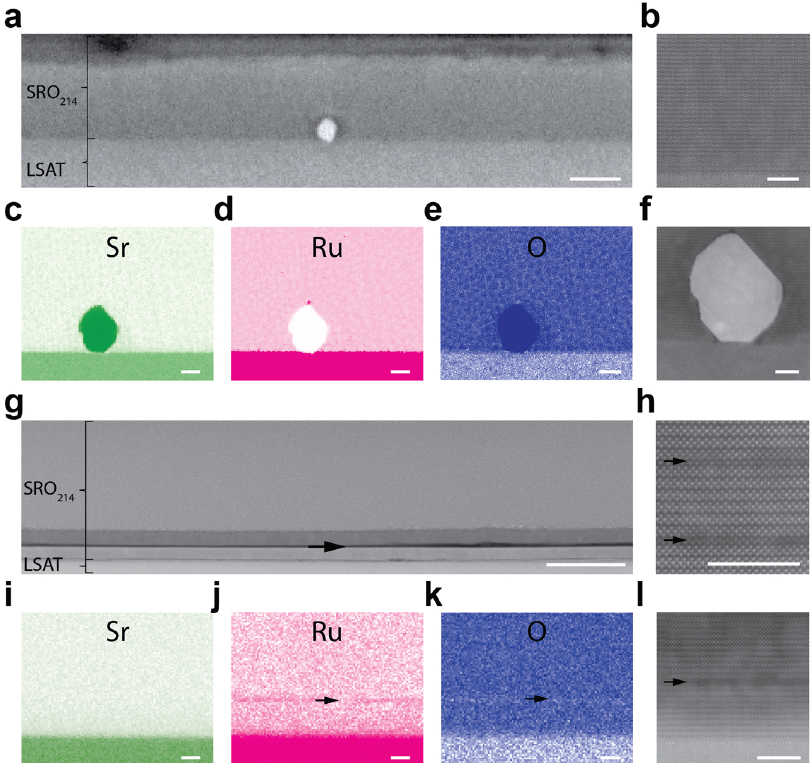
Fig. 3 Structural and chemical properties of Sr 2 RuO 4 fi lms. a – f Scanning transmission electron microscopy STEM micrographs of a superconducting fi lm of a thickness t = 66 nm ( a ) showing inclusions at the Sr 2 RuO 4 /(La 0.3 Sr 0.7 )(Al 0.65 Ta 0.35 )O 3 (LSAT) interface and high resolution HR-STEM of an area close to the same interface in ( b ). EDX maps of the inclusions in a are shown in c - e for Sr ( c ), Ru ( d ) and O ( e ) with a HR-STEM micrograph of the inclusion in f . g – l STEM micrograph of a t = 41 nm metallic fi lm ( g ) showing an interface layer of different stoichiometry (dark black line indicated with an arrow) to the rest of the fi lm with corresponding energy-dispersive X-ray EDX maps for Sr ( i ), Ru ( j ) and O ( k ). h , l HR-STEM on an area of the Sr 2 RuO 4 thin fi lm ( h ) and Sr 2 RuO 4 /(La 0.3 Sr 0.7 )(Al 0.65 Ta 0.35 )O 3 interface ( l ) showing a decreased concentration of heavy atoms in some of the layers. g – l Depleted region indicated with arrows. The scale bars are a , 50 nm, b , f , h , l 5 nm, c , d , e , I , j , k 10 nm and g , 25 nm. Note that in ( c – e ) and ( i – k ), bright regions indicate higher atomic percent. The subindex 214 refers to Sr 2 RuO 4 and LSAT corresponds to the substrate (La 0.3 Sr 0.7 )(Al 0.65 Ta 0.35 )O 3